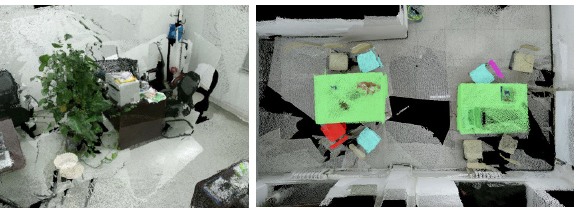
Fig. 11 Less successful cases. Left: an example view with a tree with a high score. Right: failure to find similar objects in isolated patches (the chair in